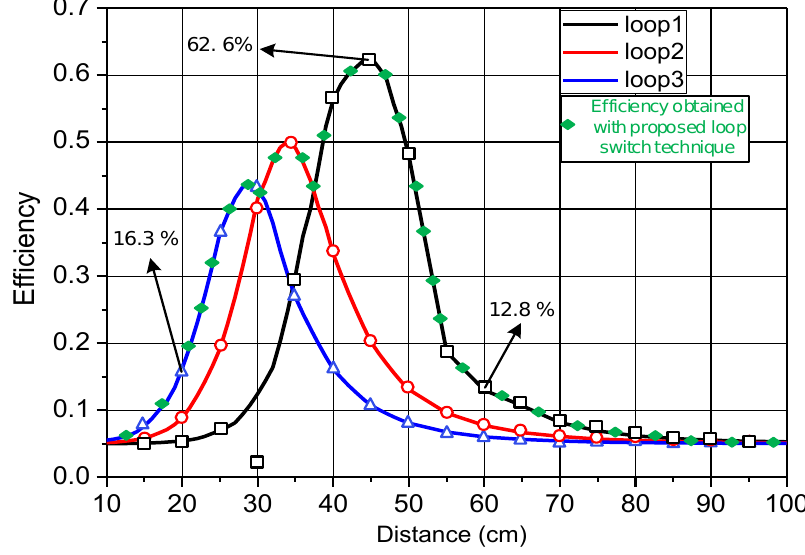
Figure 12. Measured power transfer efficiency using the RF power meter for different loops with varying d 23 in the Case 1